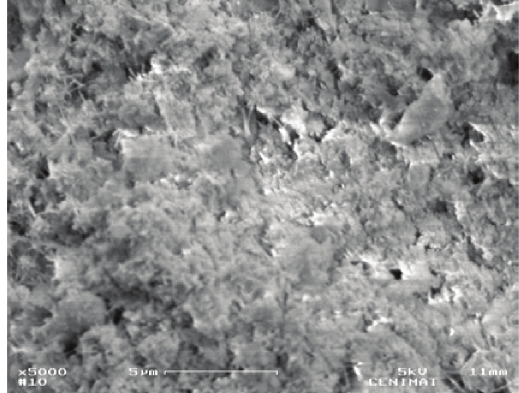
Fig. 8(c). Effect of pozzolans and AEA on air content of fresh